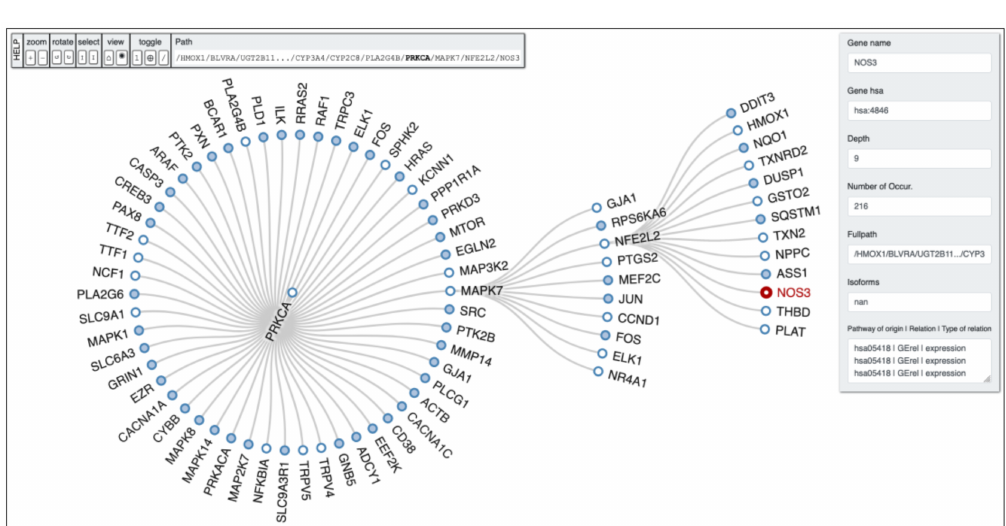
Figure 2. PETAL output tree obtained by running the depth-first search algorithm with a depth equal to 10 retrieved from the KEGG database (hsa00860) with NOS3 as target